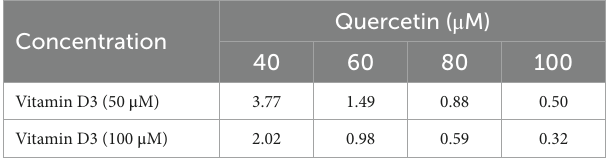
TABLE 1 Interpretation of drug combination index values in MDA- MB-231.